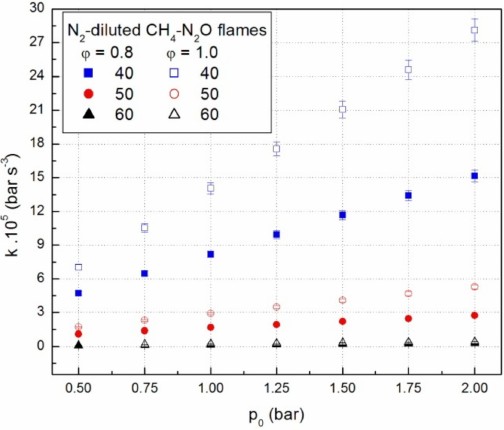
Figure 3. Cubic law constants of deflagrations in CH 4 -N 2 O mixtures diluted with N 2 . For N 2 -diluted CH 4 -N 2 O mixtures the expansion coefficients delivered by equilibrium calculations on their adiabatic isobaric combustion are given in Table 1. At each composi- tion, the expansion coefficients increase slightly with the initial pressure; at constant initial pressure, the expansion coefficients decrease with the increase of the diluent